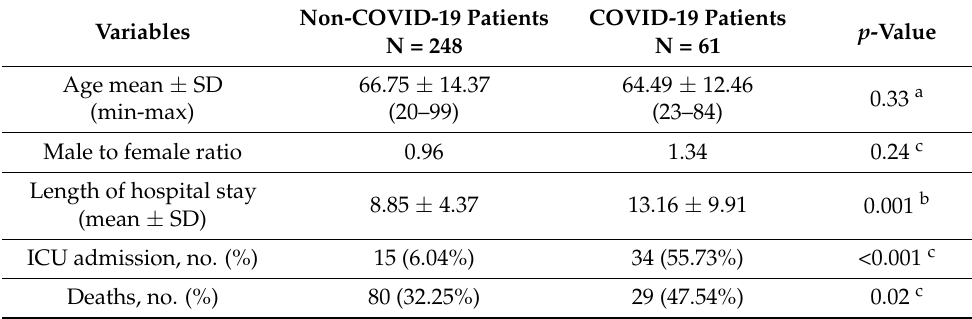
Table 2. Characterics of COVID-19 period